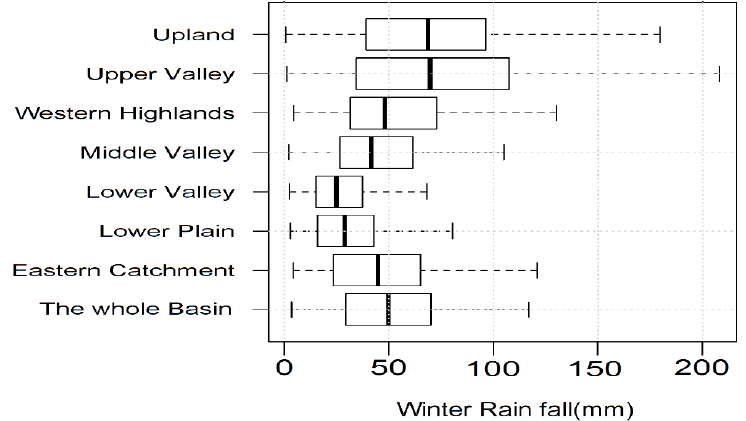
Figure 13. Box plot showing the variability of winter rainfall over the study areas for the period 1900–2016.